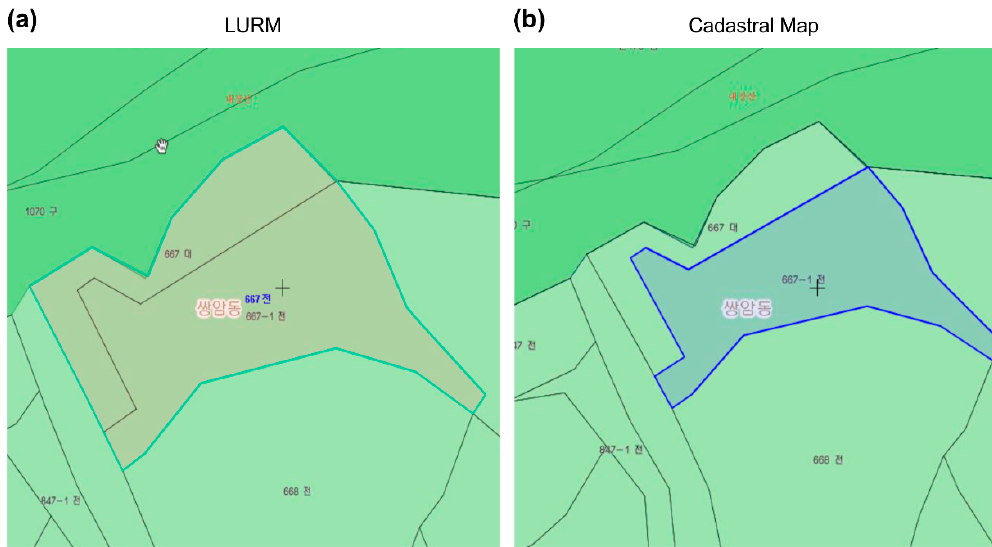
Figure 5. Discordance between the LURM and cadastral map. ( a ) Public project area (brown area); six zones (small river, national park, natural environment, restriction of livestock, production management, and environmental conservation). ( b ) Public project area (blue area); three zones (small river, restriction of livestock, production management). Source: Chonbuk Provincial Government [82].